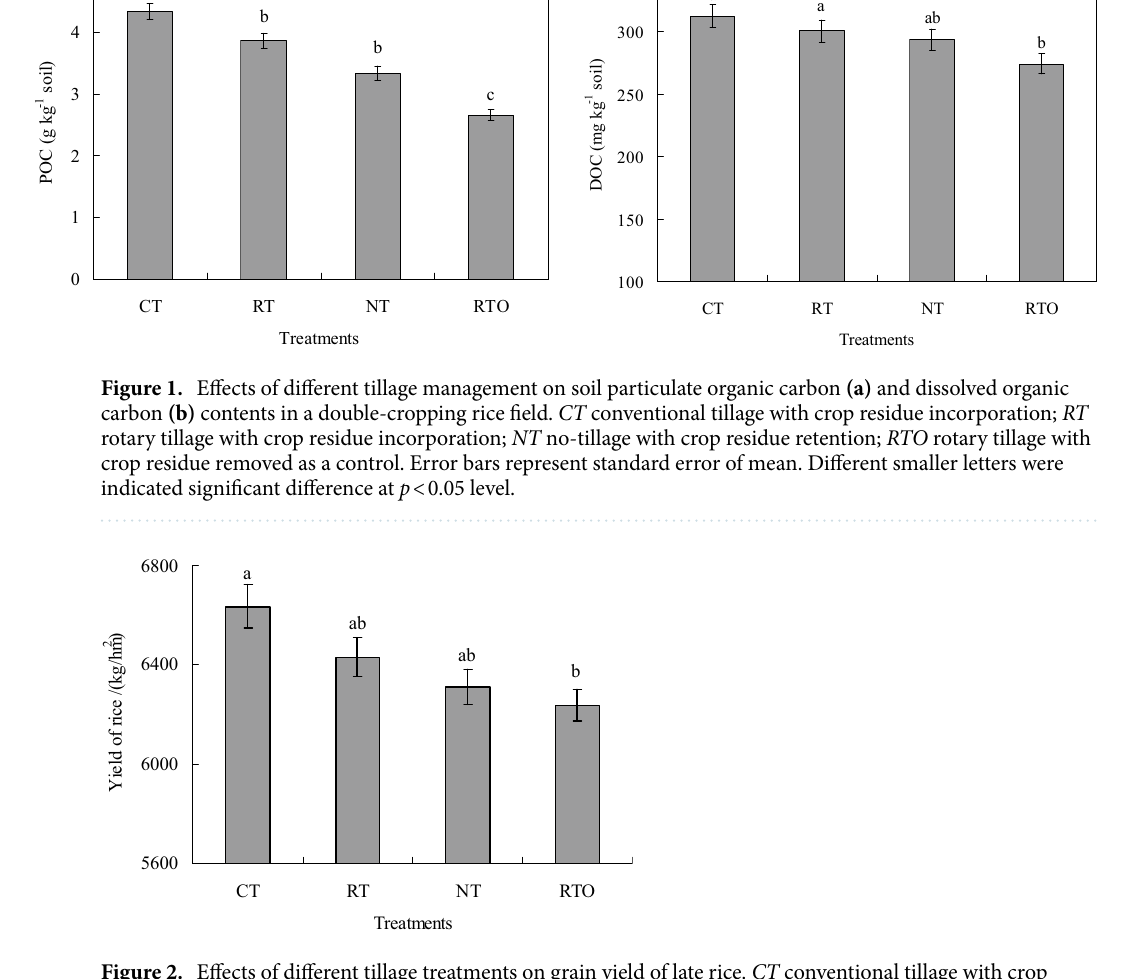
Figure 2. Effects of different tillage treatments on grain yield of late rice. CT conventional tillage with crop residue incorporation; RT rotary tillage with crop residue incorporation; NT no-tillage with crop residue retention; RTO rotary tillage with crop residue removed as control. Error bars represent standard error of mean. Different smaller letters were indicated significant difference at p < 0.05